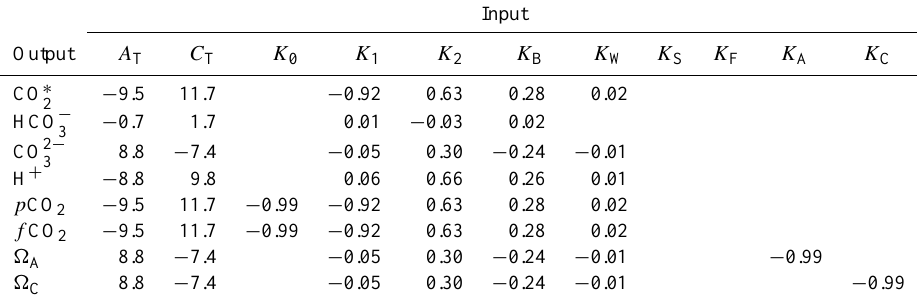
Table 11. Ratio of relative change a,b between output and input variables c, d (∂y/y)/(∂x i /x i ) .